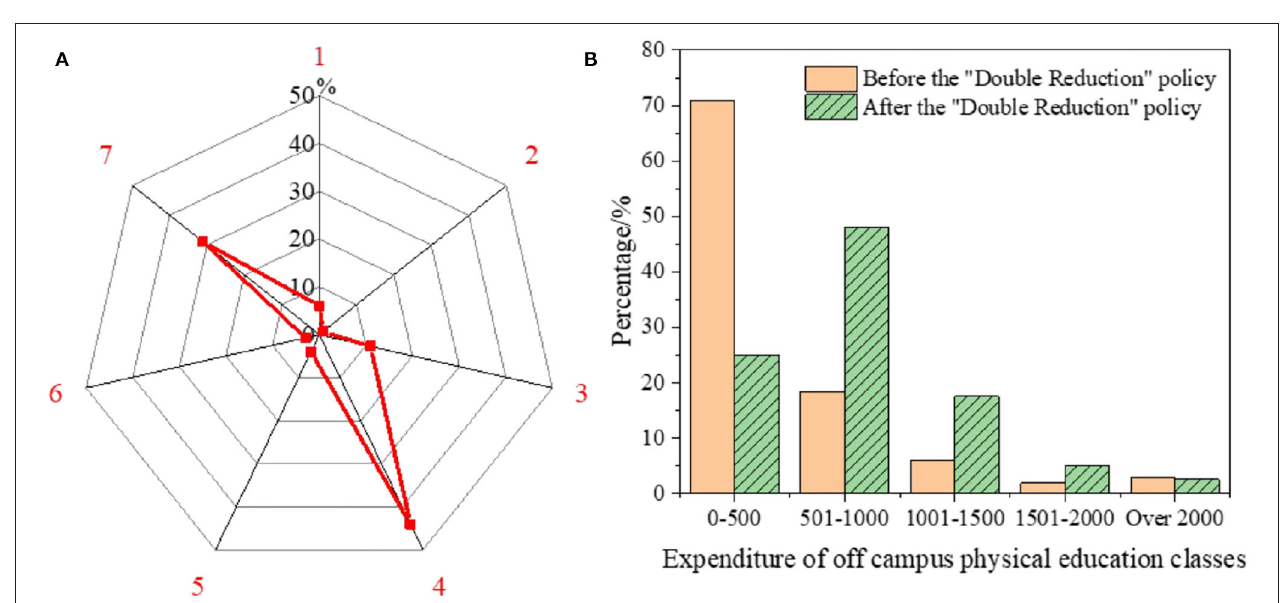
FIGURE 8 | Statistical results of registration purpose and cost of off-campus sport class [ (A) : proportion distribution of registration purpose of off-campus sport class; (B) : cost expenditure of off-campus sport class].